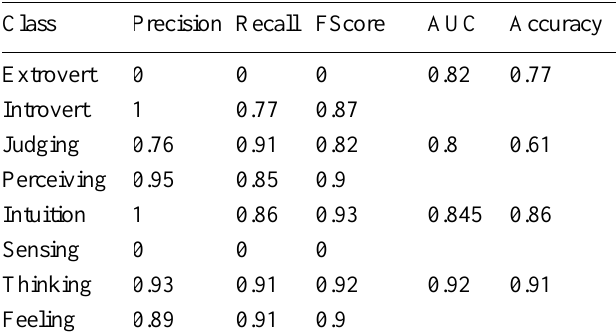
Random Forest result with basic